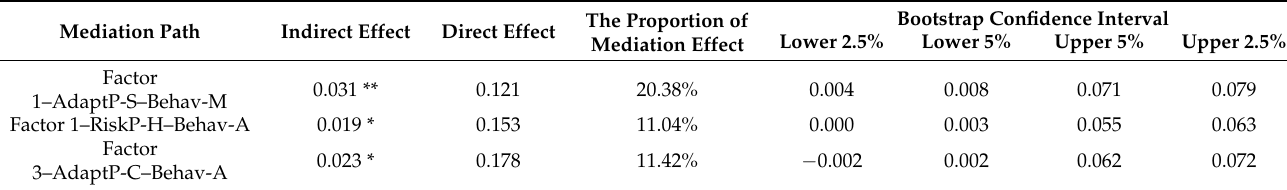
Table 5. The calculation of mediating effects and Bootstrap test.